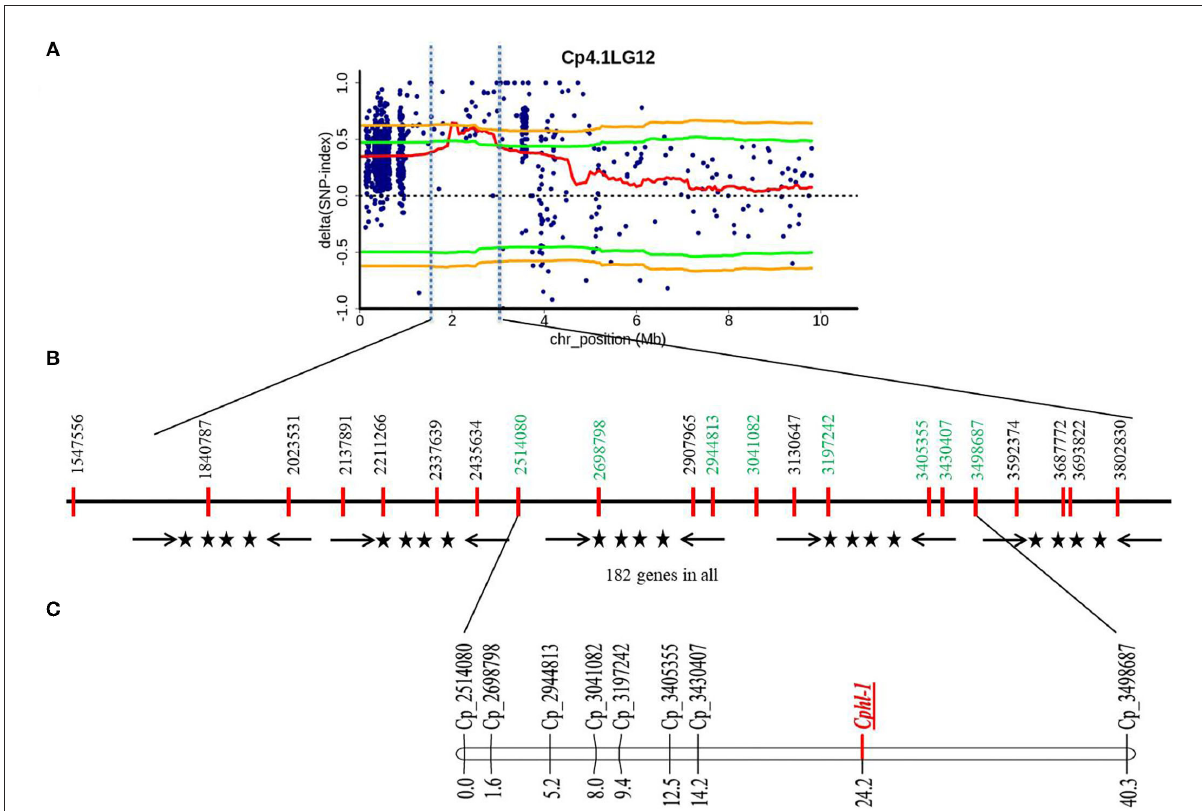
FIGURE2 Physical and genetic position of QTL region governing hull-less seed trait in C. pepo on chromosome 12. (A) 1 SNP index graph from hulled and hull-less bulks, Orange line indicates 99% confidence interval and the green line indicates 95% confidence interval upper/lower side; (B) Genomic position of SNPs in QTL region selected for designing KASP assay where SNP shown in green were polymorphic and used for linkage map construction; (C) Partial Genetic linkage map of chromosome 12 from the HP111 × HLP36 F 2 population showing the position of the hull-less locus ( Cphl-1 ).